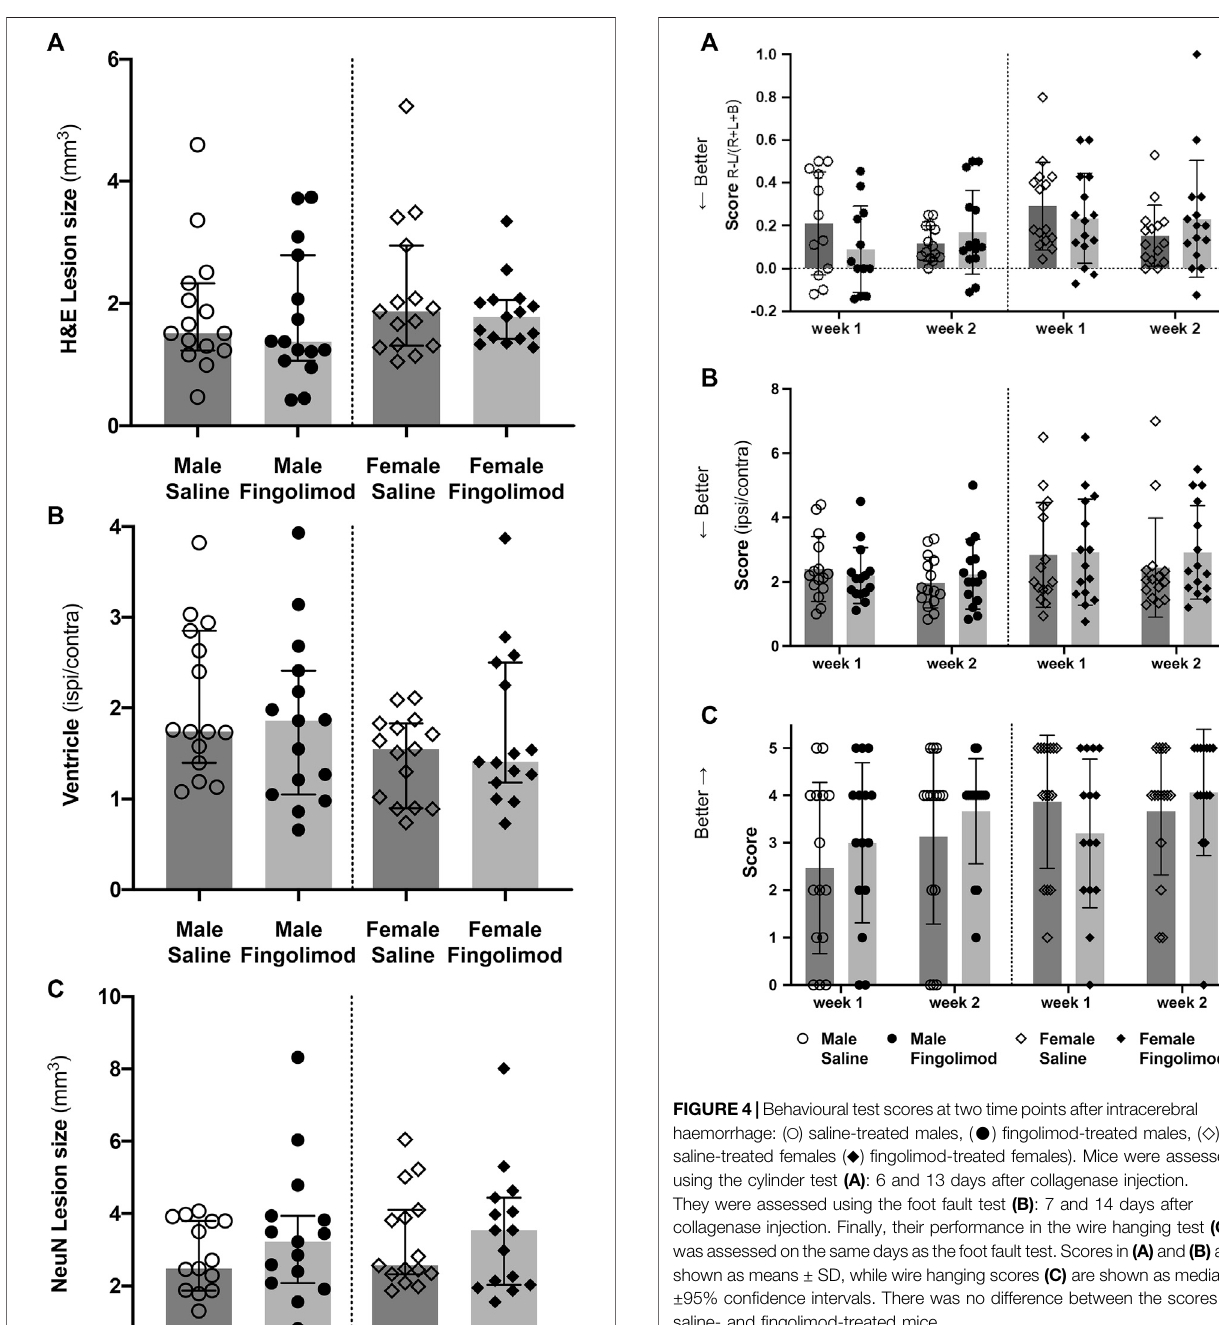
Frontiers in Pharmacology |